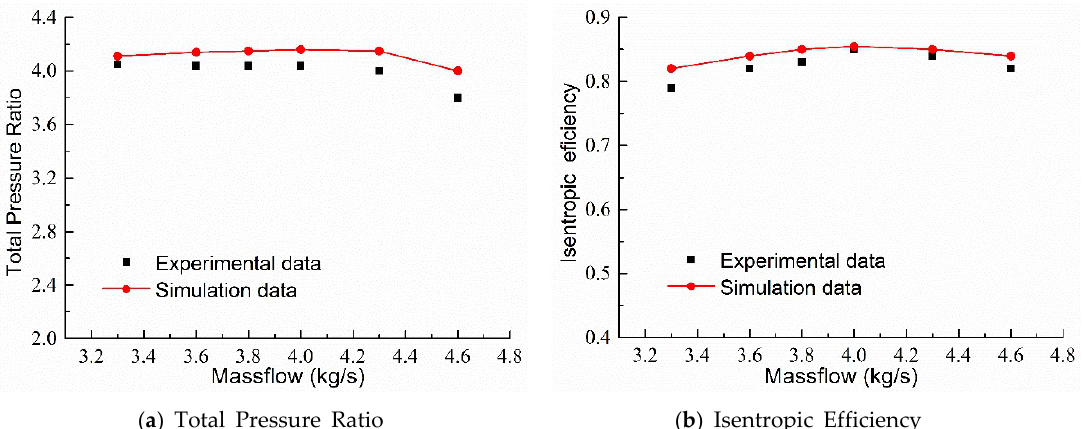
Figure 3. Comparison of the simulation and experimental data of the Krain impeller